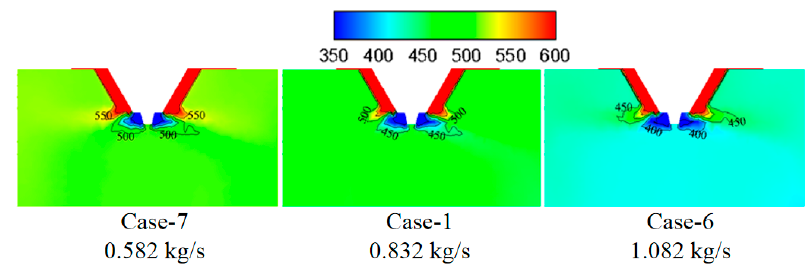
Figure 10. Turbulence kinetic energy under different waste water flow rates (m 2 /s 2 ). Figure 11. Temperature under different wastewater flow rates (K). Figure 11. Temperature under different wastewater flow rates